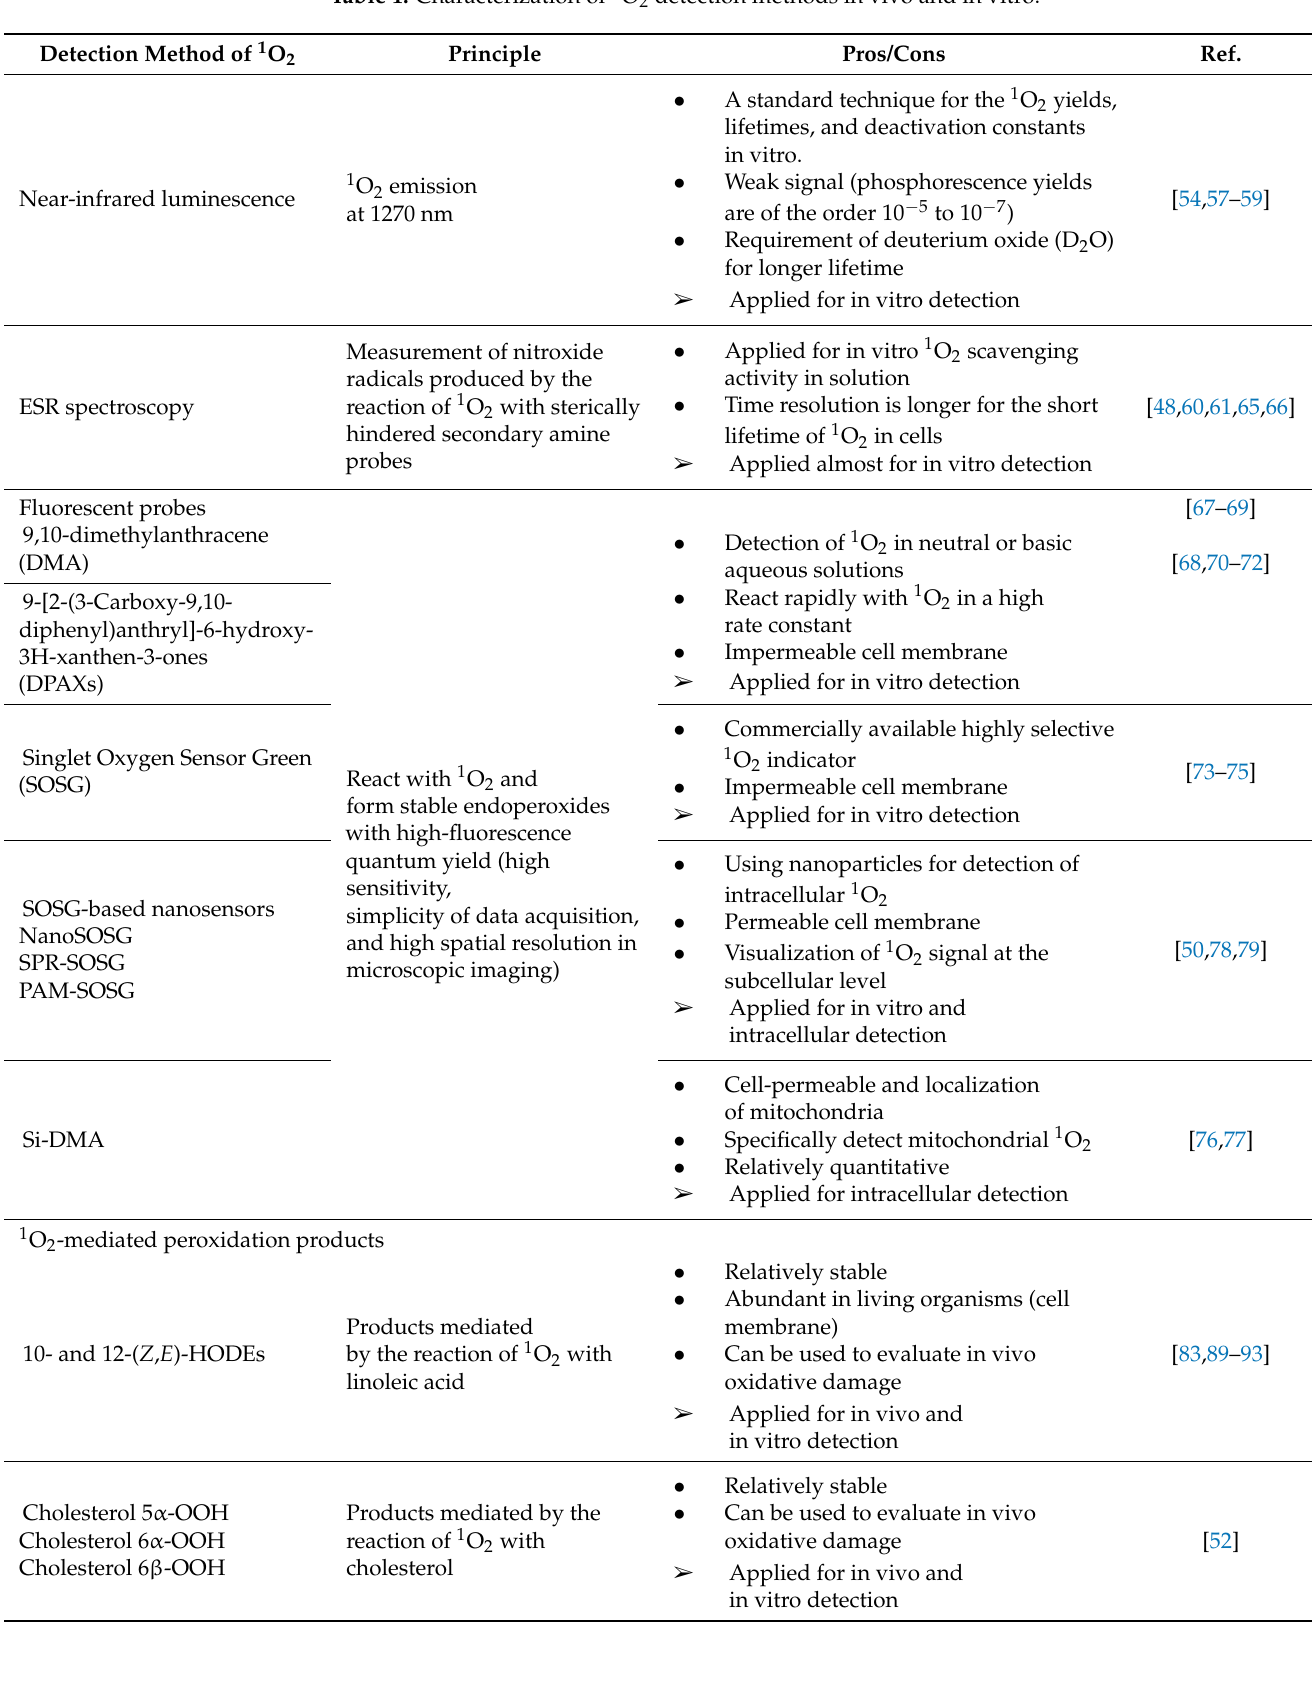
Table 1. Characterization of 1 O 2 detection methods in vivo and in